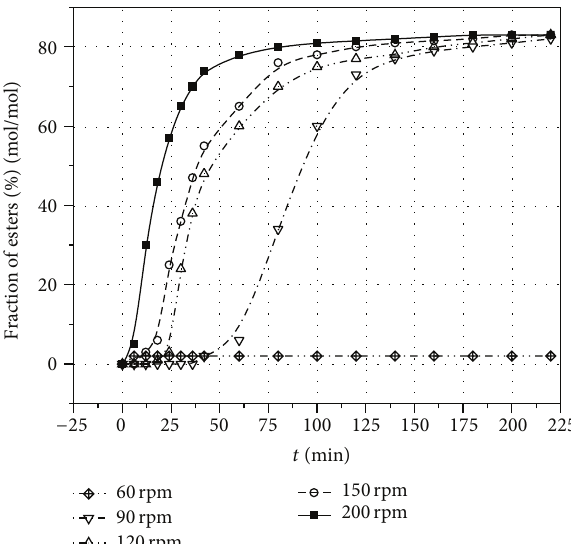
Figure3:Effectofmixingintensityontheoilconversionintomethyl ester.